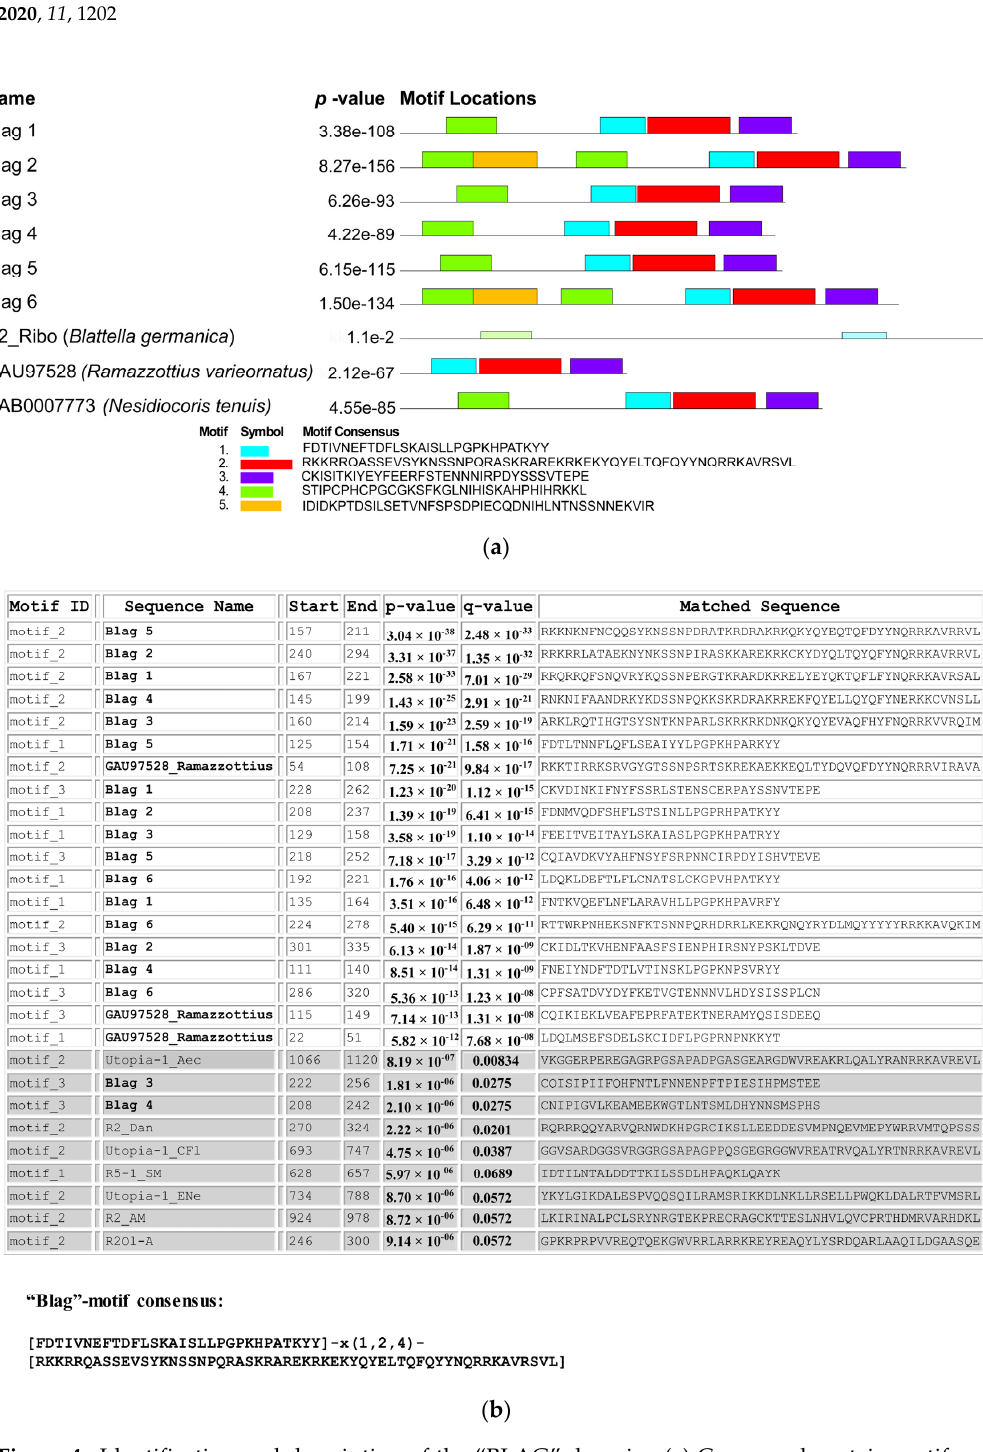
Figure 4. Identification and description of the “BLAG” domain. ( a ) Conserved protein motifs are identified using MEME software. Significantly represented motifs are graphically depicted by bars of different colors corresponding to their predicted position. The sequences included in the analysis are those of the BLAG 1–BLAG 6 retrotransposons, the R2 retrotransposon of B. germanica (R2_Ribo), and retrotransposons identified in the genomes of N. tenuis and R. varieornatus (GenBank Acc. ## CAB0007773 and GAU97528, respectively). The consensus sequence of each revealed motif is listed under the graphic. It was shown that motifs ## 1–3 are present in all analyzed sequences except for the R2 retrotransposon of B. germanica . ( b ) The result of FIMO software analysis. This program searches a set of sequences for occurrences of known motifs, treating each motif independently. Previously described motif ## 1–3 were analyzed using the database including the ORFs of the BLAG